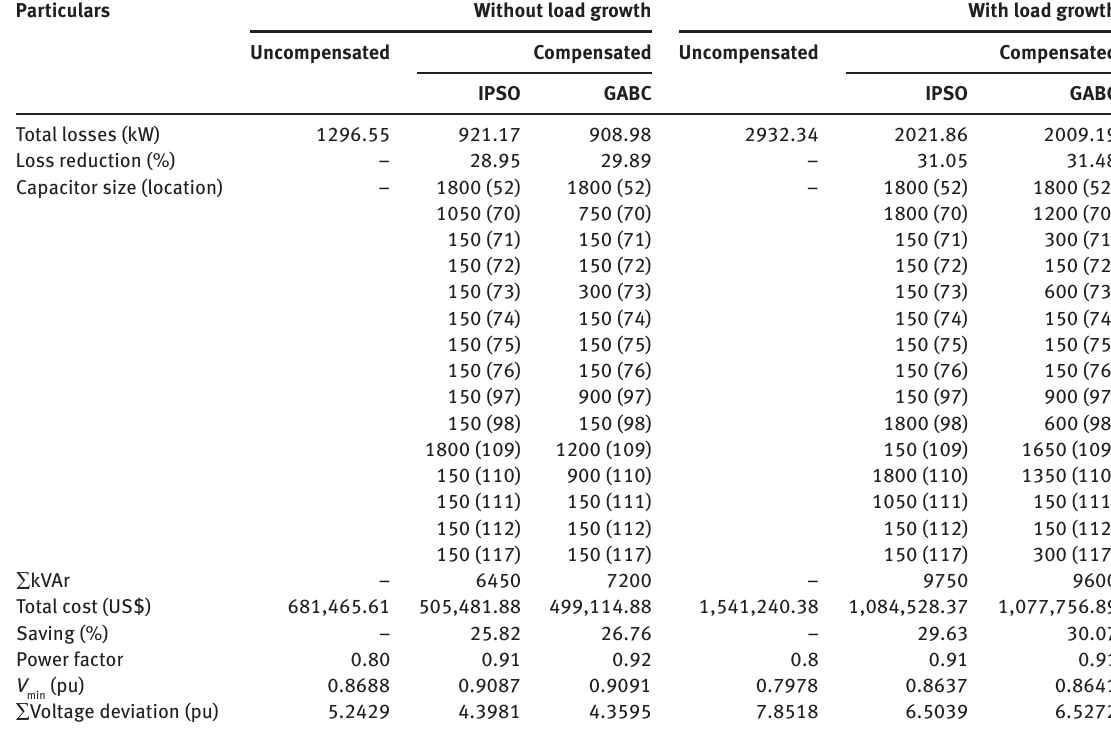
Table 15: Simulation Results of the 118-Bus Distribution Network after SC Placement Using the PLI Approach.